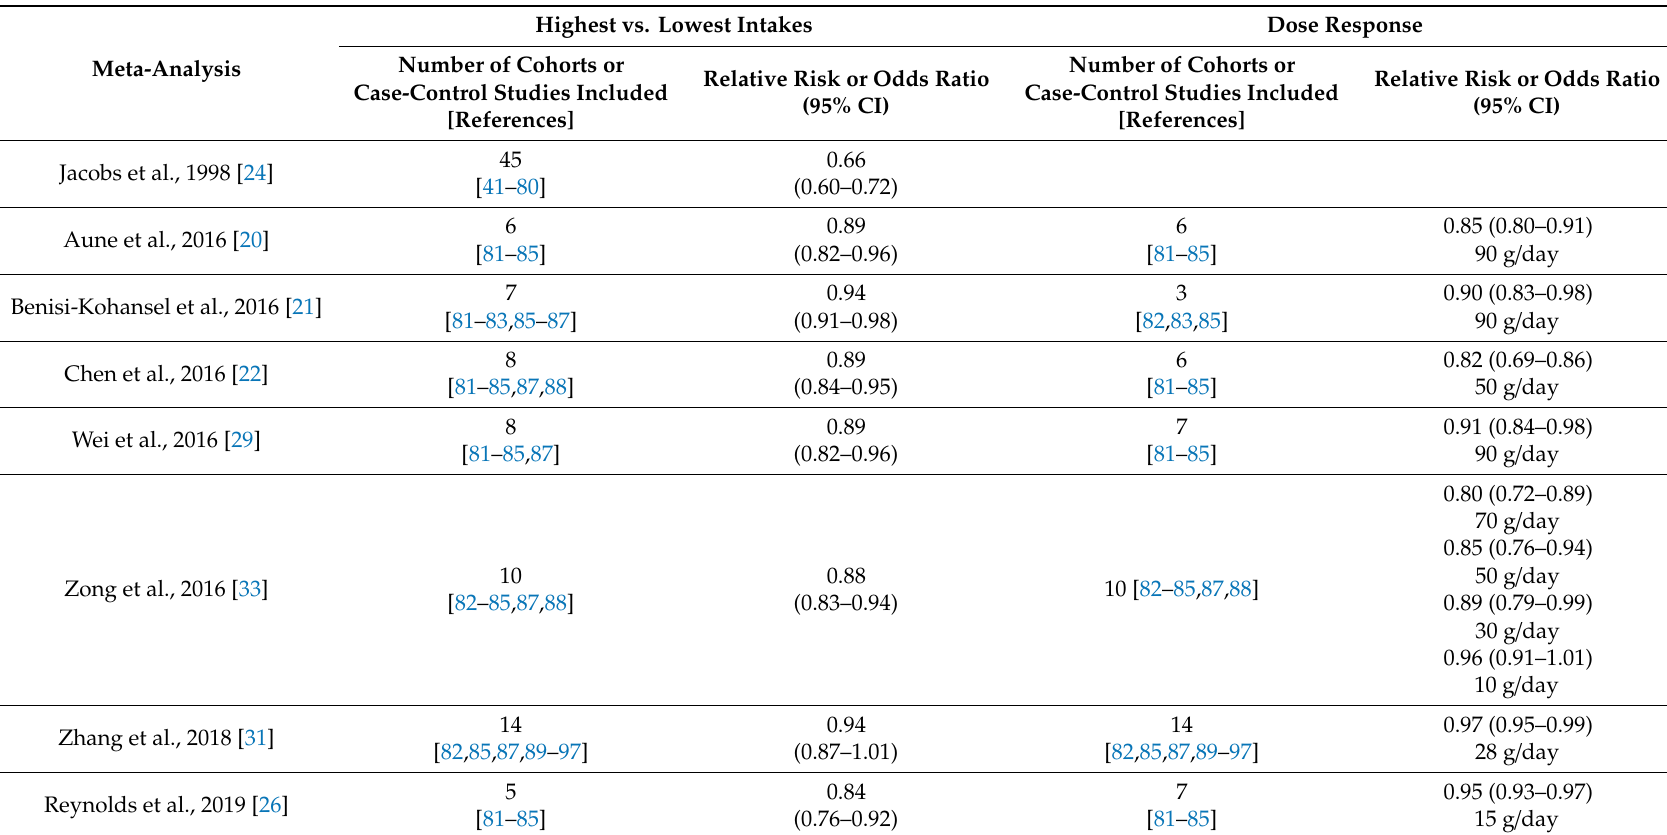
Table 1. Whole grain intake and risk of cancer mortality *: Results from meta-analyses of observational cohort and case-control